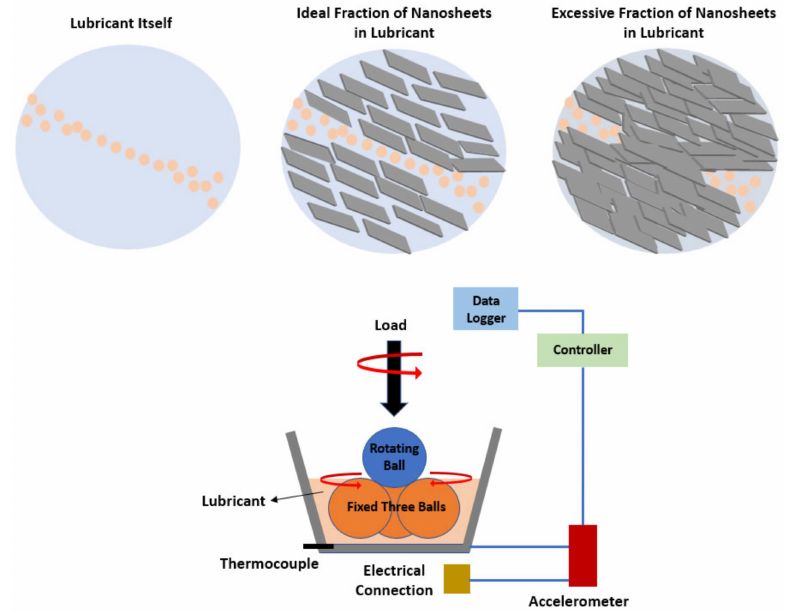
Figure 6. Schematic diagram of a four-ball tribometer and effect of the concentration of